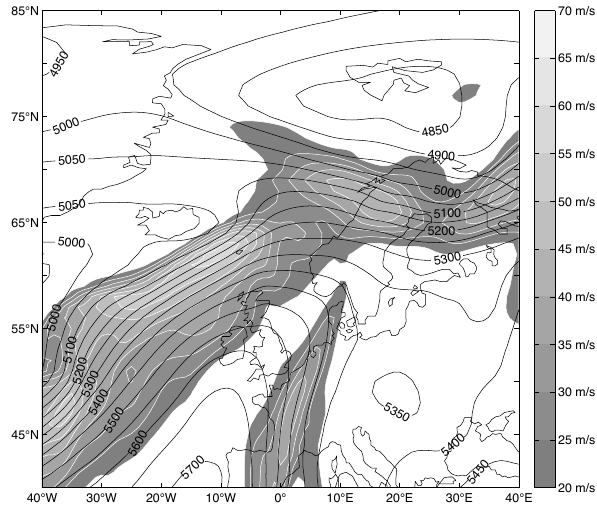
Fig. 2a. Synoptic chart for 00:00UTC on 24 January 2003: Geopo- tential height at 500hPa (contours) and wind speed